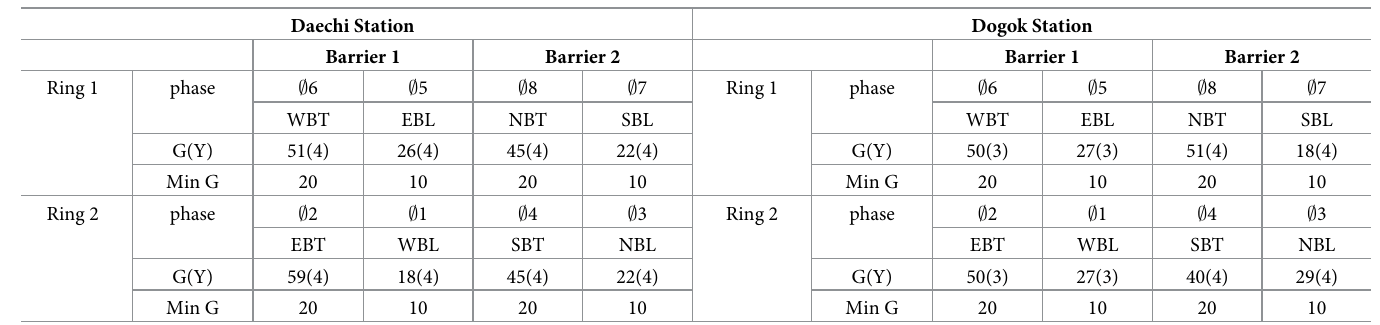
Table 1. The fixed time plans of the simulated